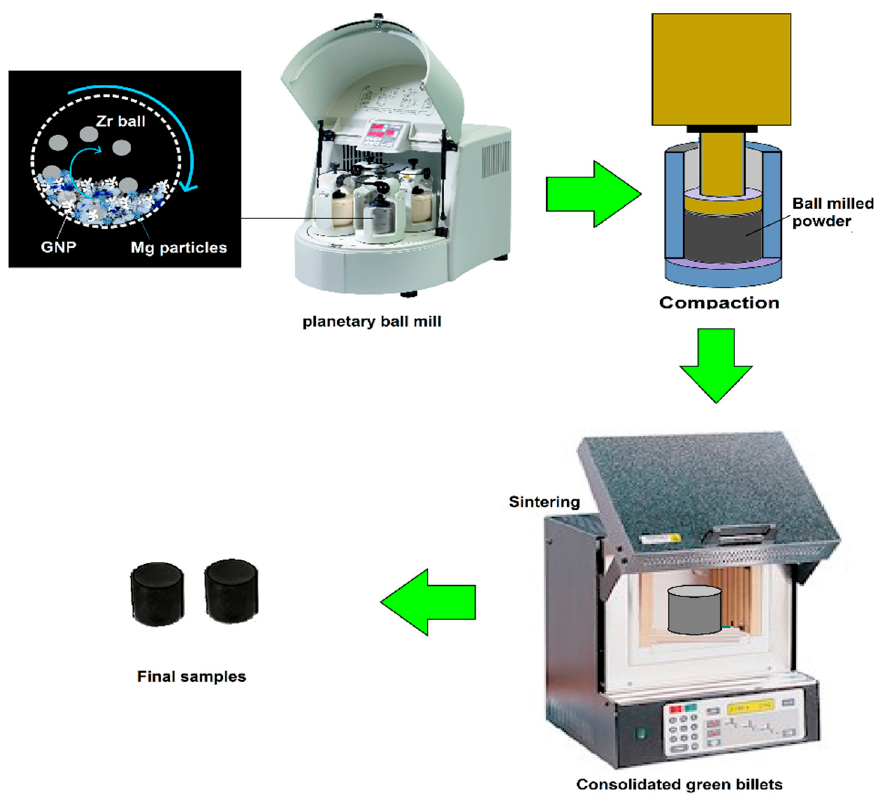
Figure 6. Illustration of the powder metallurgy method for manufacturing Mg-based composites with GFN nanofillers.